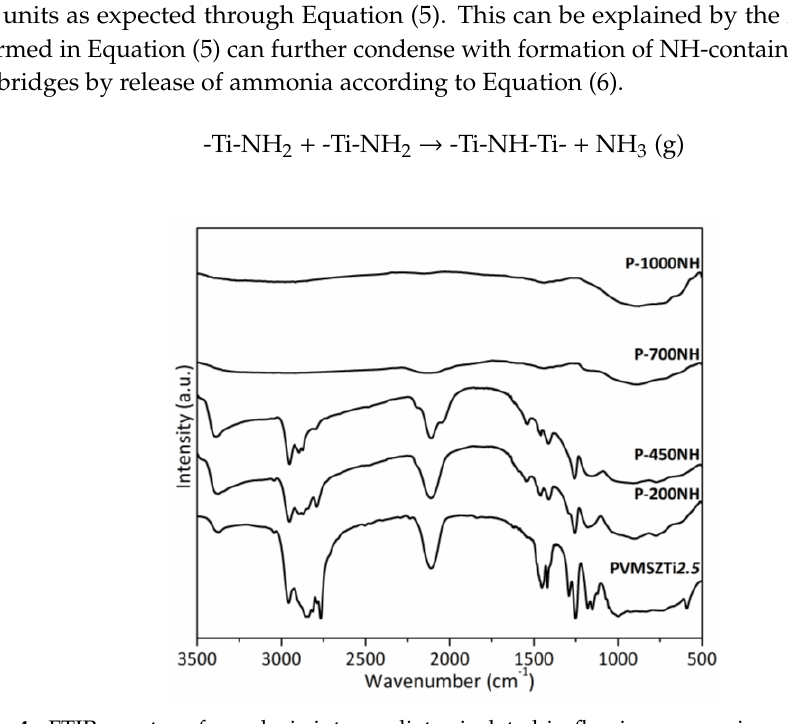
Figure 4. FTIR spectra of pyrolysis intermediates isolated in flowing ammonia and derived from PVMSZTi 2.5 .